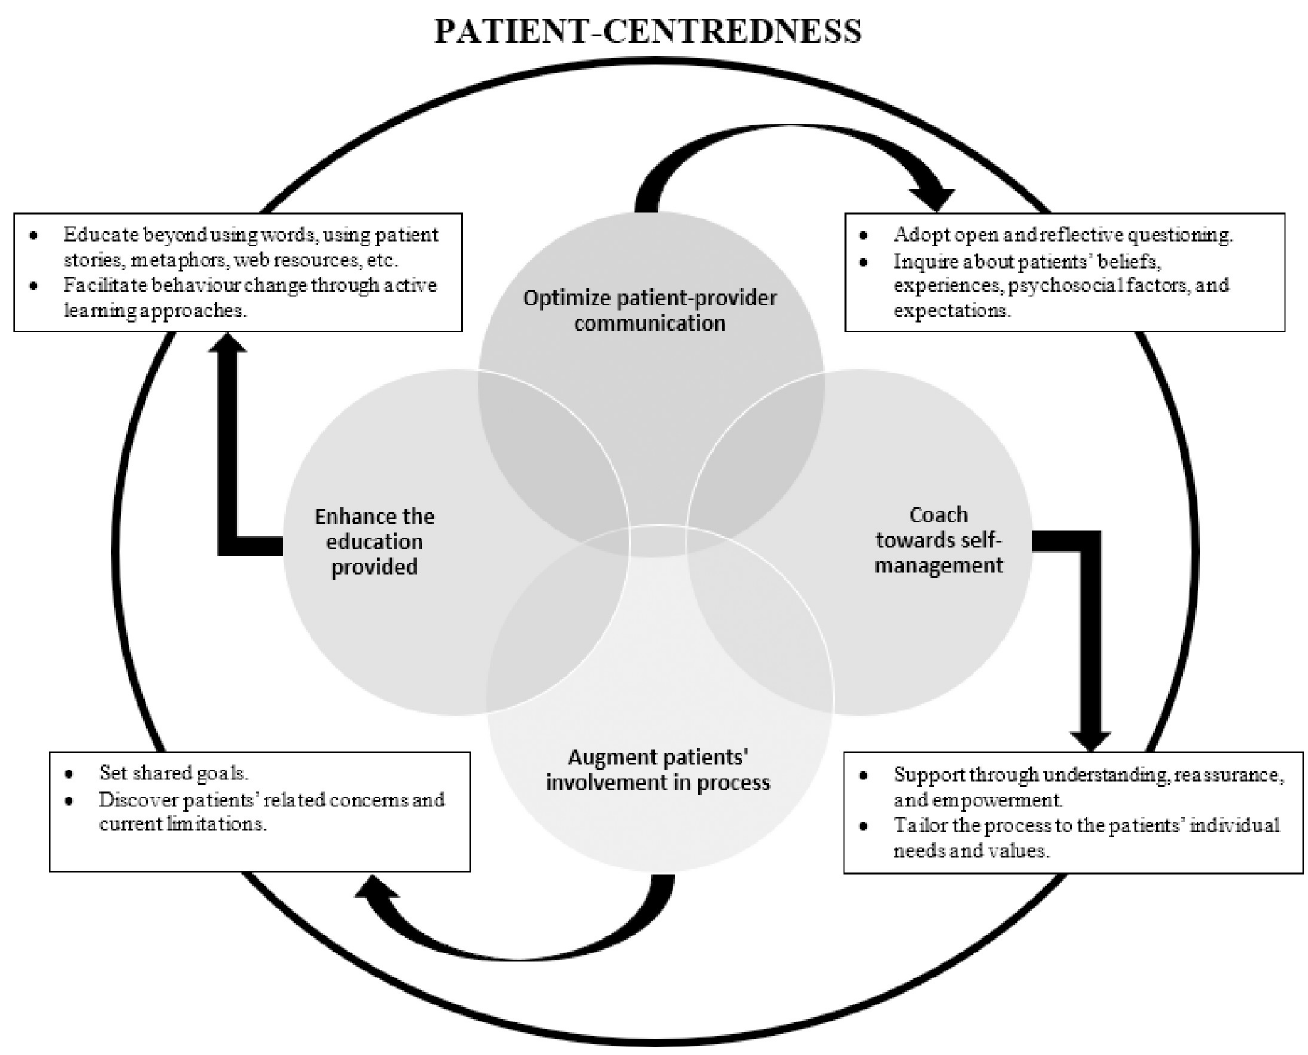
Fig 2. Proposed patient-centredness